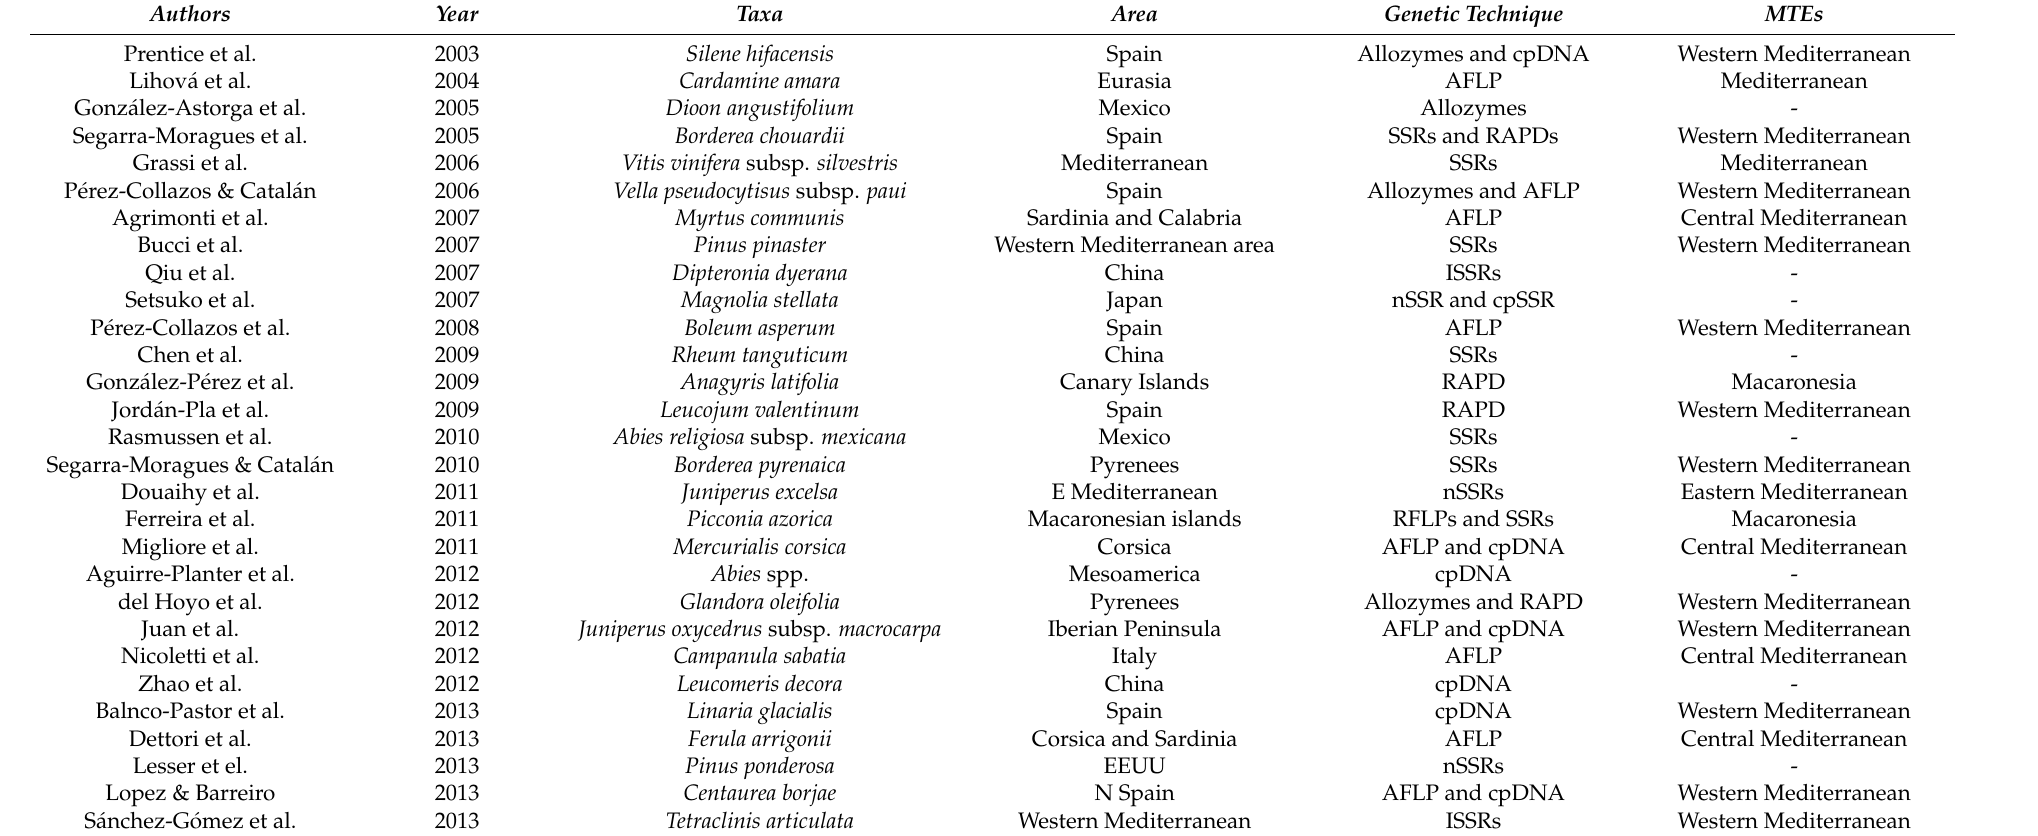
Table A1. Research articles obtained after the Scopus search using the keywords “plant conservation”, “phylogeography” and “Mediterranean”, and the criterion “AND” that forced the results to include the three keywords and after the screening to only consider plant-related research articles in which conservation proposals were made considering the phylogeographic